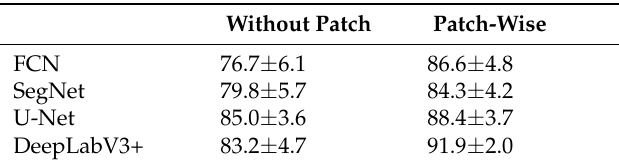
Table 2. DSC values (in percentage) of prostate whole gland (WG) segmentation by FCN, SegNet, U-Net, and DeepLabV3+ for test images from the UKMMC